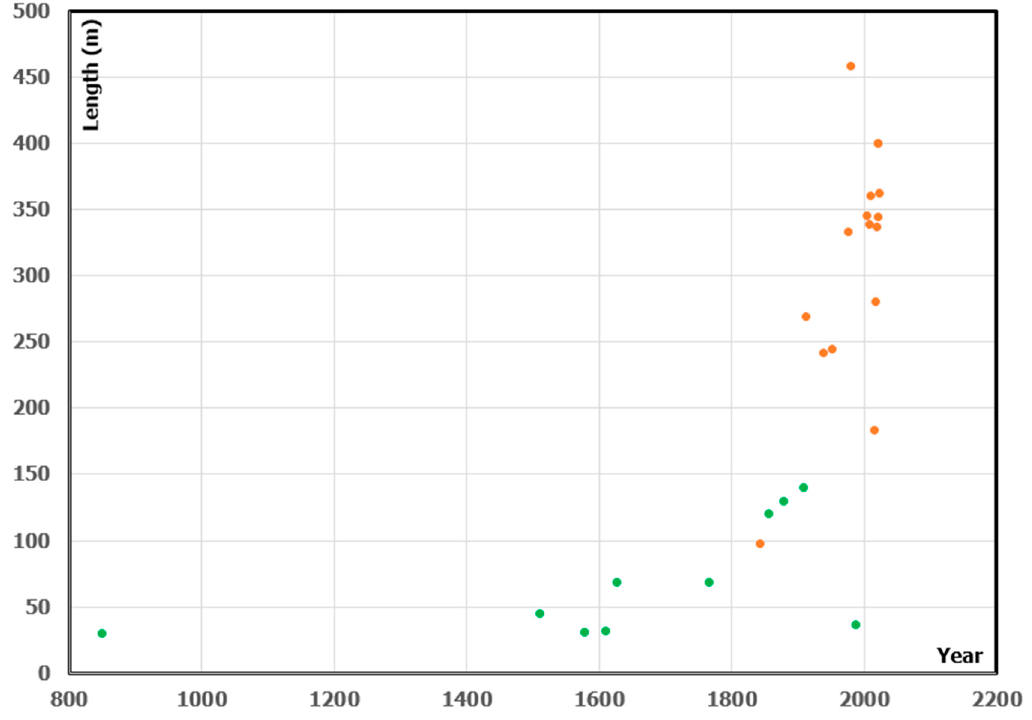
Figure A1. Ship lengths for wooden (green) and steel (orange) vessels by year.